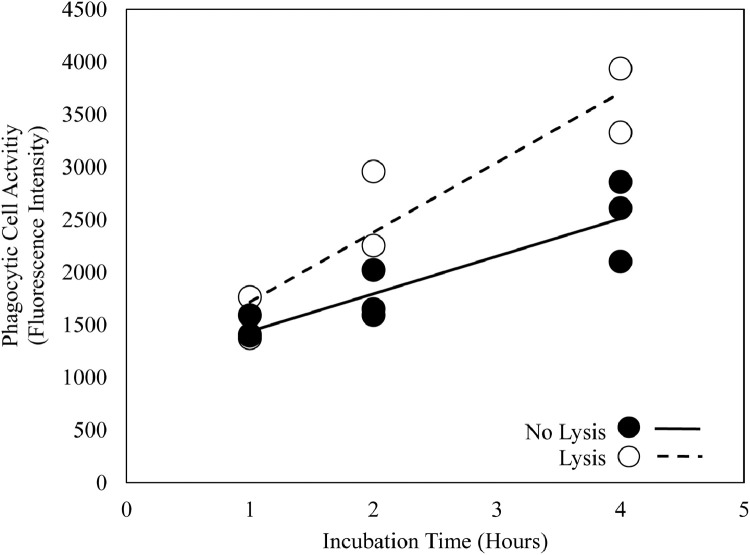
Relationship between phagocytic cell activity and incubation time in untreated fathead minnow kidney cell suspensions and cell suspensions where erythrocytes where lysed (n = 2–3).